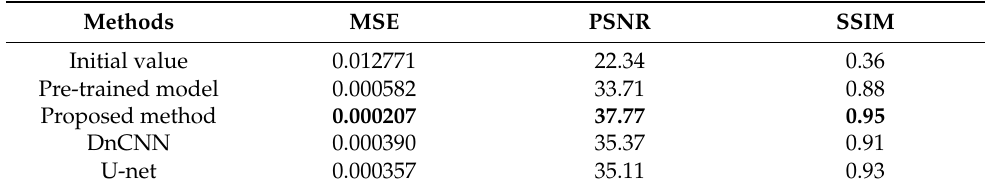
Table 5. Quantitative comparison of the third synthetic example.